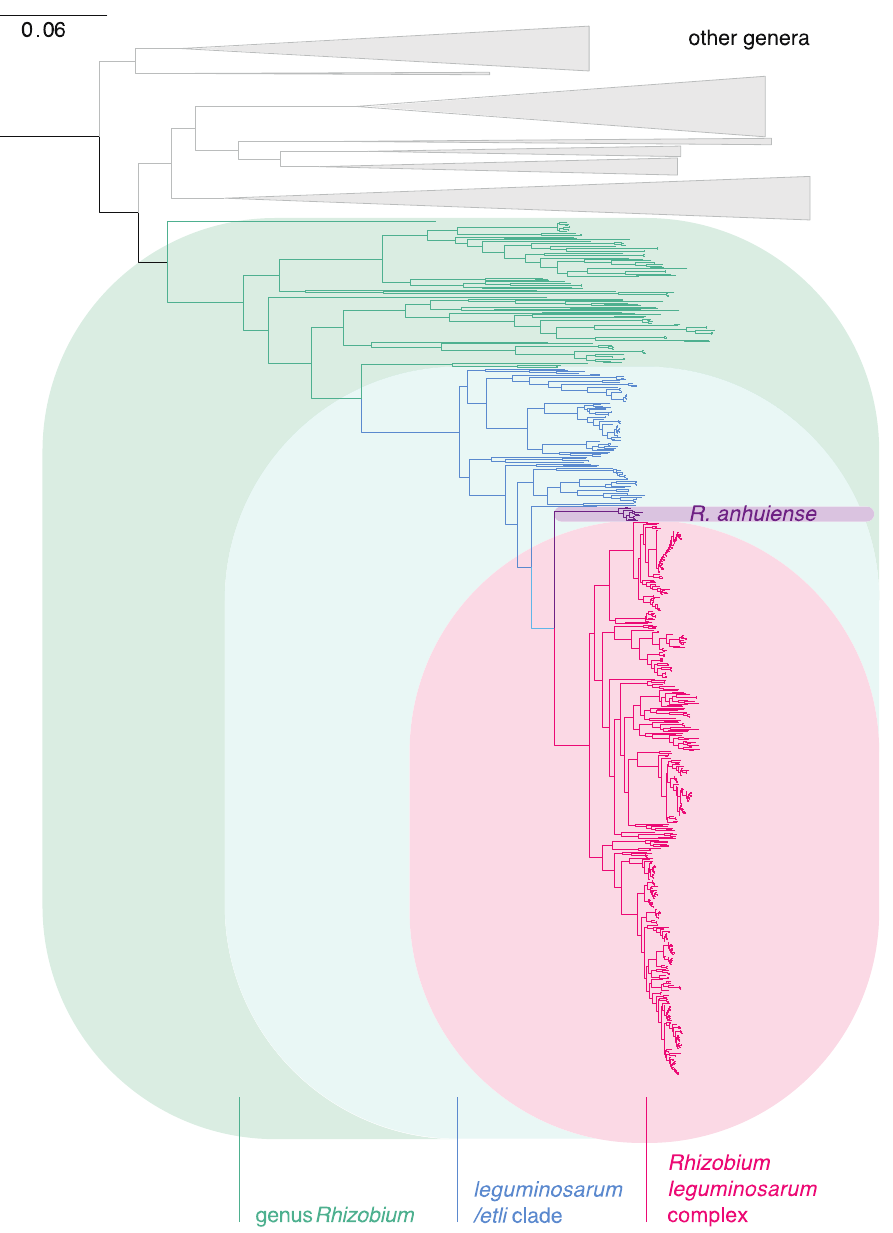
Figure 1. Phylogeny, based on 120 core genes, of genomes assigned to the genus Rhizobium by NCBI (NCBI:txid379). Only the 797 genomes that had all 120 genes were included. Genomes that are not currently included in the genus Rhizobium are indicated in the basal clades, collapsed by genus: Pararhizobium, Mycoplana, Agrobacterium, GTDB g__Rhizobium_A [20], Pseudorhizobium, Neorhizobium, and Allorhizobium (top to bottom). The tree was rooted using strain FKL33 (not shown).